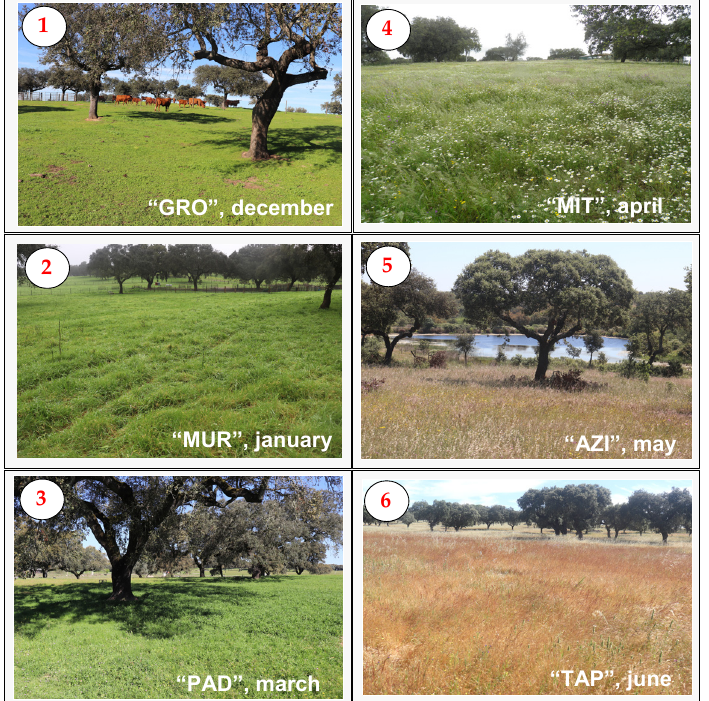
Figure 3. Montado ecosystem: evolution of the phenological state of the pasture during the vegetative cycles (2018/2019 and 2019/2020).